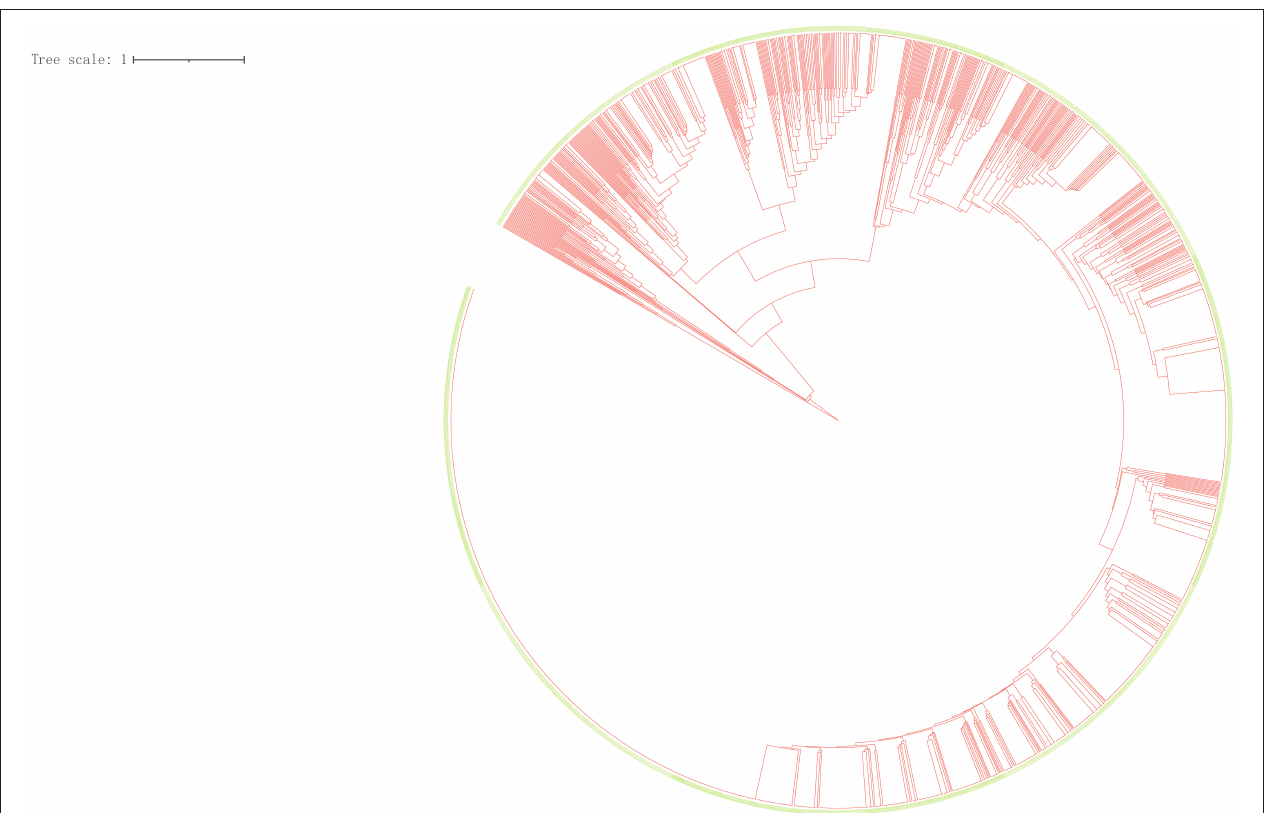
FIGURE 2 | Clustering tree of 2,098 tuberculosis isolates. Red represents the branches of the phylogenetic tree, and green means the ID of the